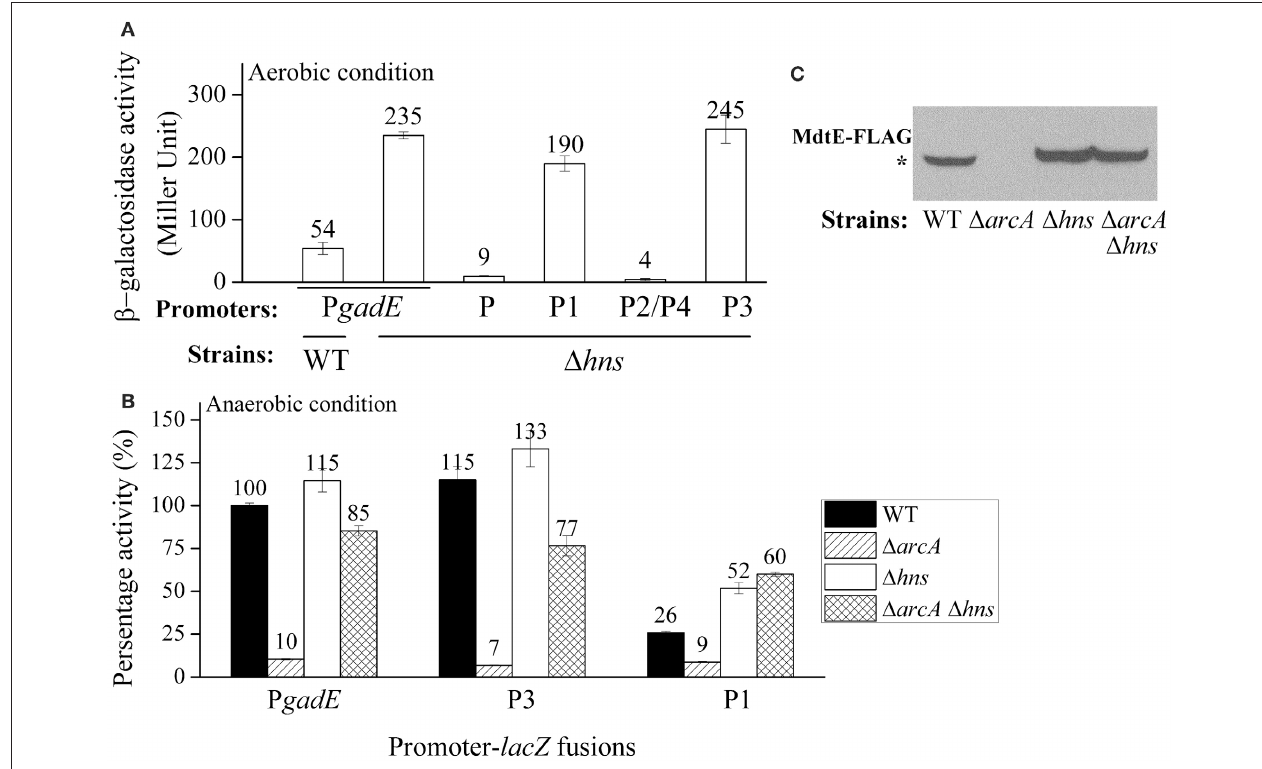
FIGURE 6 | ArcA antagonizes the H-NS mediated repression of gadE under anaerobic growth. (A) Promoter activity of P gadE and its truncations under aerobic condition determined by β -galactosidase activity of corresponding lacZ fusions in WT and (cid:2) hns strains; (B) Promoter activity of P gadE and its truncations under anaerobic condition determined by β -galactosidase activity of corresponding lacZ fusions in WT, (cid:2) arcA , (cid:2) hns , and (cid:2) arcA (cid:2) hns strains; (C) Protein